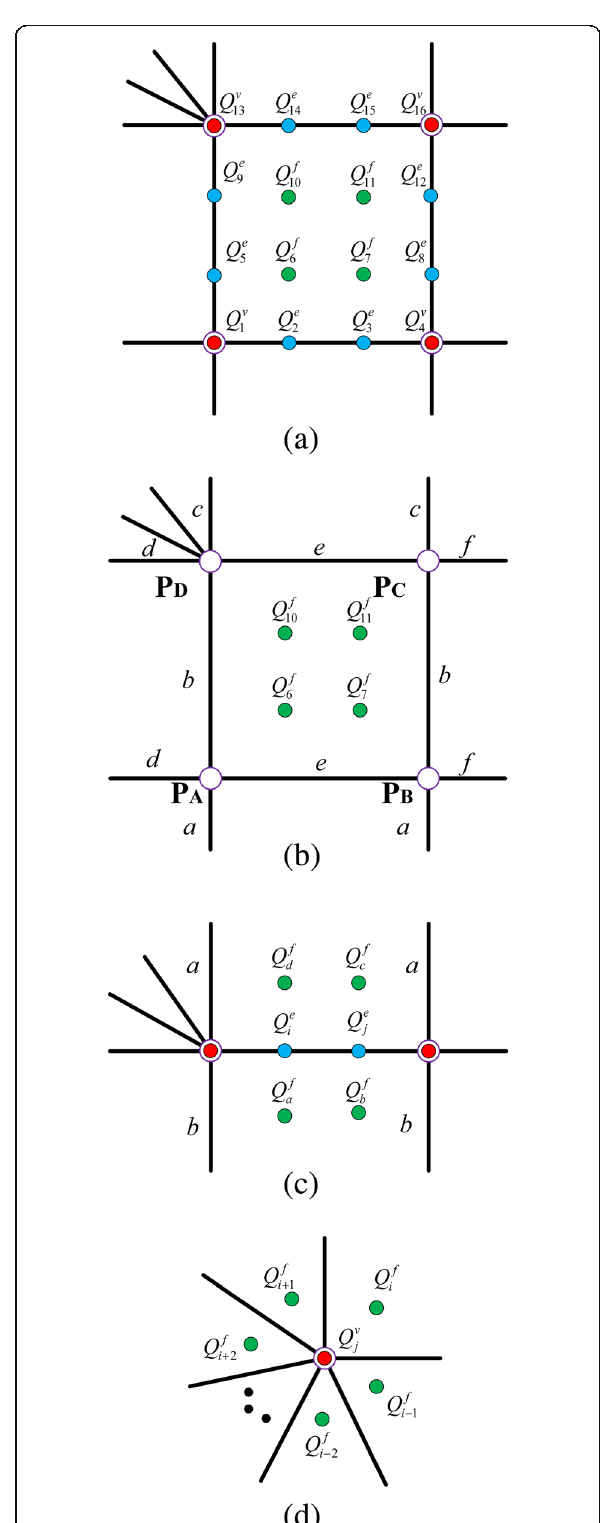
Fig. 9 Scheme of calculating two-ring neighborhood of the extraordinary points